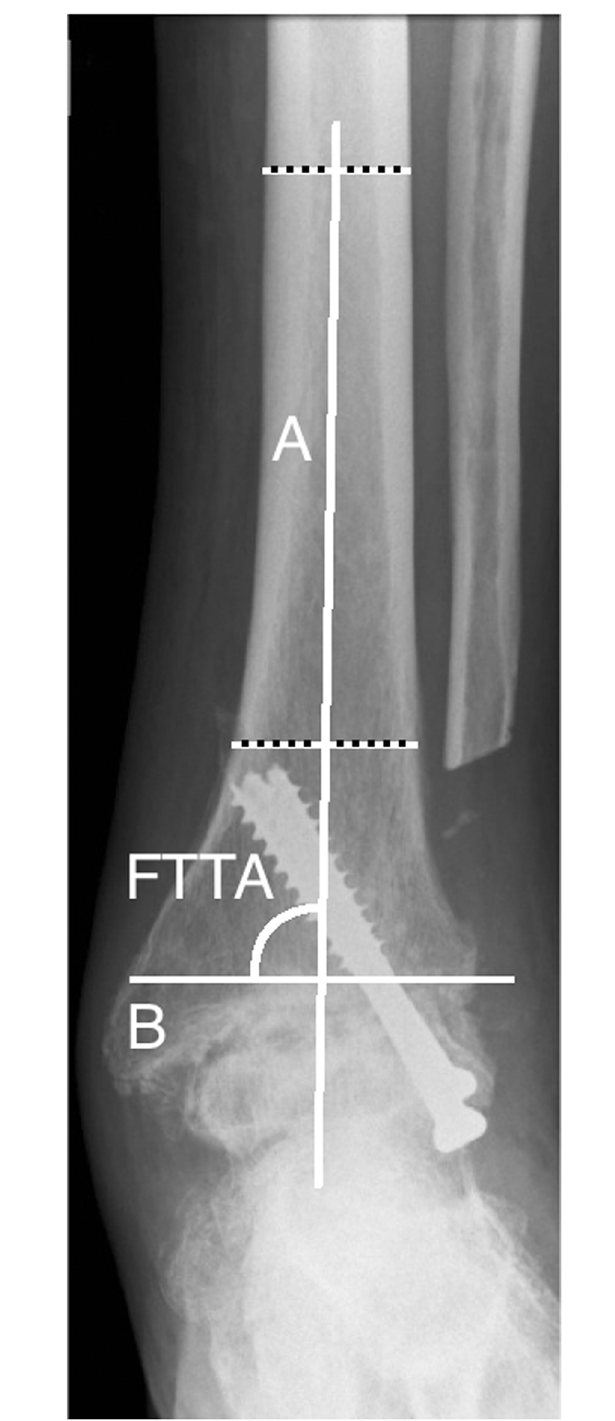
Fig 1. Anterior-posterior radiograph ankle arthrodesis. Anterior to posterior ankle radiograph with the measurement of the frontal tibiotalar angle (FTTA). The FTTA is the superomedial angle between the two axes A and B. A = longitudinal axis of the tibia, created by connecting two points in the middle of the proximal and the distal tibial shaft (according to method B). B = axis of the talus, defined by a line drawn through the talar